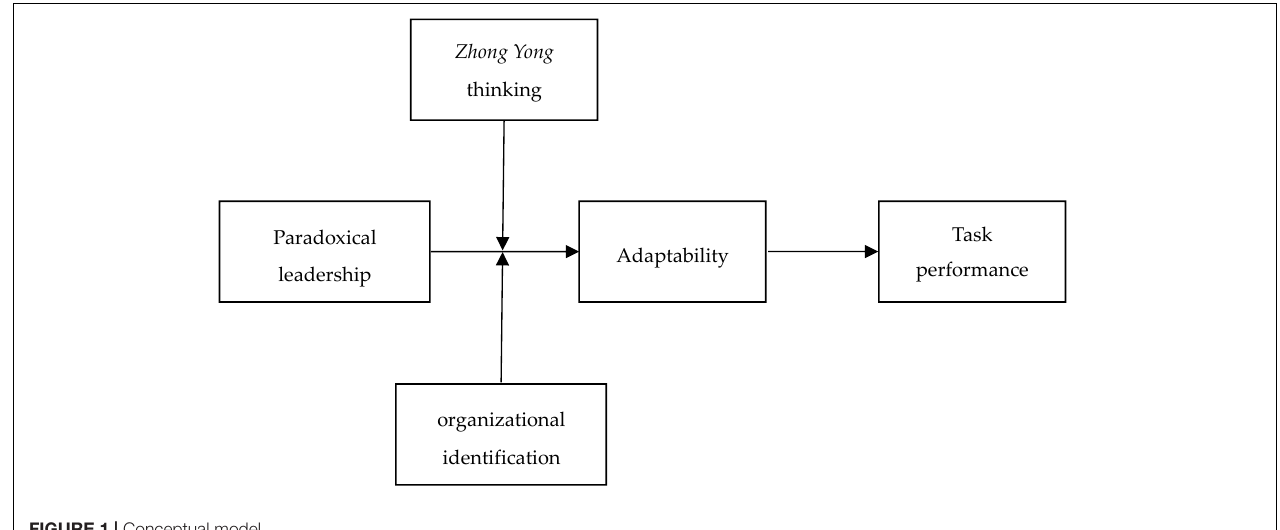
FIGURE 1 | Conceptual